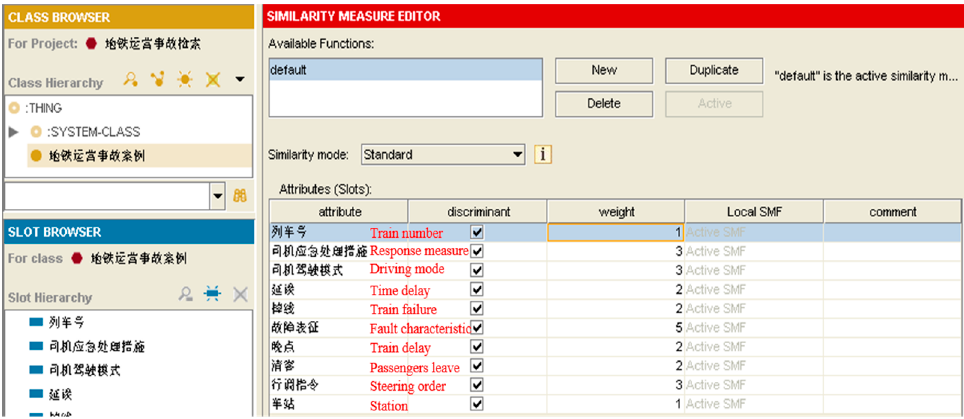
Figure 9. Setting interface of the case attributes weights.